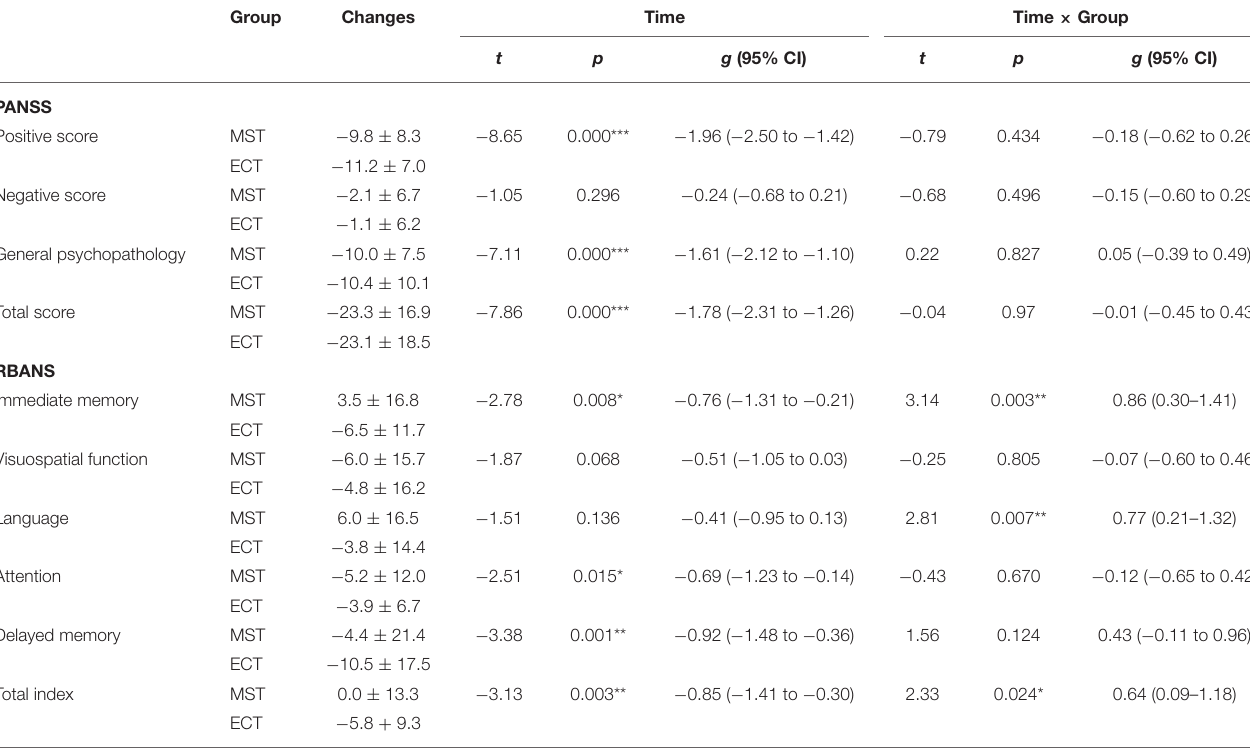
TABLE 2 | The effects of MST and ECT on psychotic symptoms and cognitive functions in the intention-to-treat dataset.